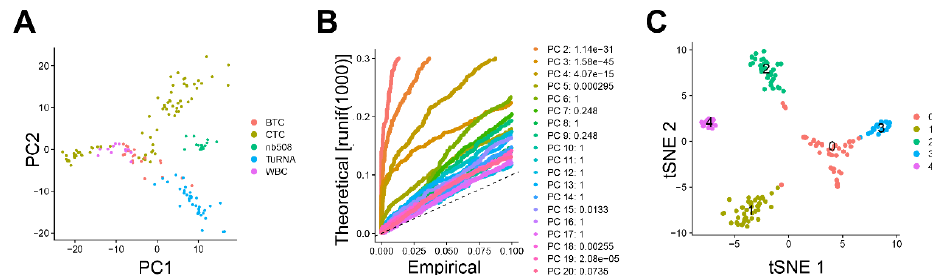
Figure 2. Clustering of murine cells after single-cell sequencing. There are 157 cells from the GSE51372 dataset that were taken into the analysis, including 75 circulating tumor cells (CTCs) from the genetically engineered mouse model (“CTC”), 34 primary tumor cells (“TuRNA”) (from which 10 or 100 pg RNA of diluted bulk RNA were taken), 20 EGFP-positive primary bulk tumor cells (“BTC”), 16 single tumor cells from NB508 cell line (“NB508”), and 12 WBCs from a control mouse (“WBC”). ( A ) Principal component analysis (PCA) of the cells. ( B ) JackStraw plot of the first 20 principal components (PCs). The distribution of p values for each PC with a uniform distribution (dashed line). The first five PCs show strong enrichment of features with low p values (solid curve above the dashed line). ( C ) t-Distributed Stochastic Neighbor Embedding (t-SNE) plot of 157 cells. All cells can be distributed into five clusters (cluster 0, 1, 2, 3, and 4). Cluster 0 consists of murine pancreatic CTCs, bulk tumor cells (BTCs), and white blood cells (WBCs). Cluster 1 only contains CTCs. Cluster 2 consists of diluted bulk RNA (TuRNA) and BTCs. Cluster 3 only contains CTCs and cluster 4 represents NB508 cells. BTCs, bulk tumor cells; CTCs, circulating tumor cells; PC, principal component; t-SNE, t-Distributed Stochastic Neighbor Embedding; TuRNA, RNA of the bulk tumor; WBC, white blood cells.